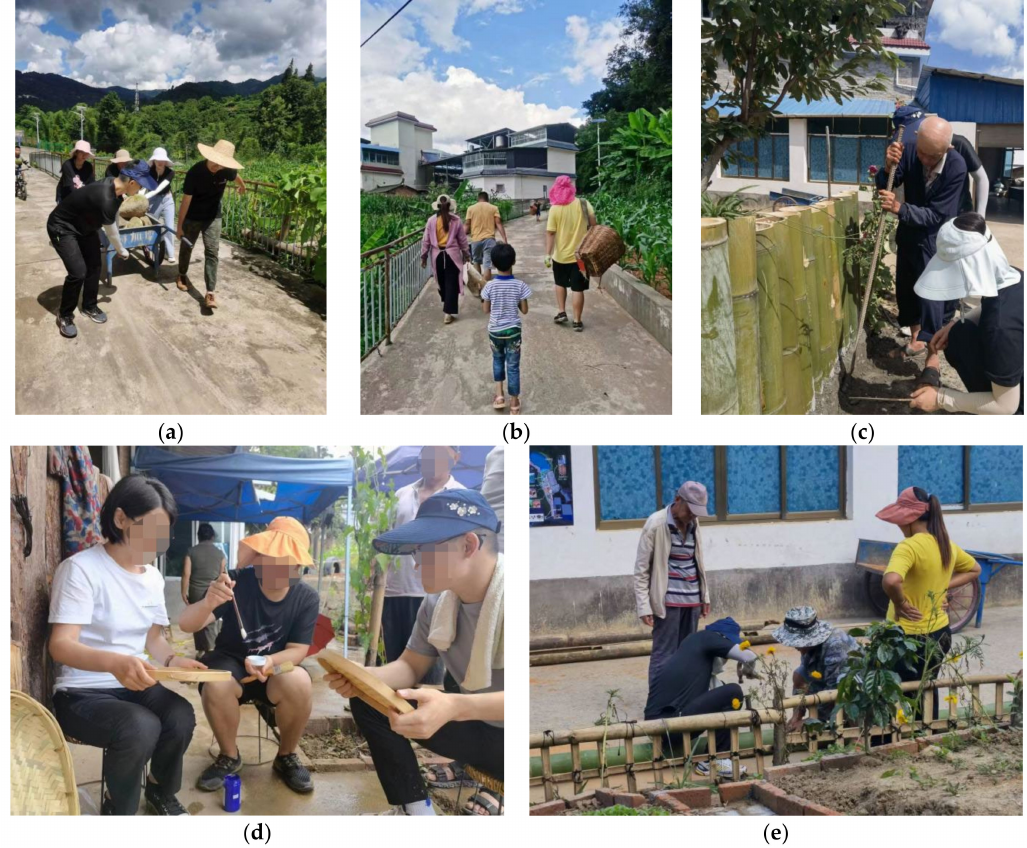
Figure 8. Planners working with local villagers on rebuilding their farmyards in front of their houses and behind. ( a ) Planning team transferring stone with villagers; ( b ) volunteer students carrying building materials with one local family; ( c ) elderly villagers assisting planners in building a fence aside the farmyard; ( d ) planners decorating wall art with villagers; and ( e ) planners building a bamboo stockade with the villagers. Source: the authors, taken in August